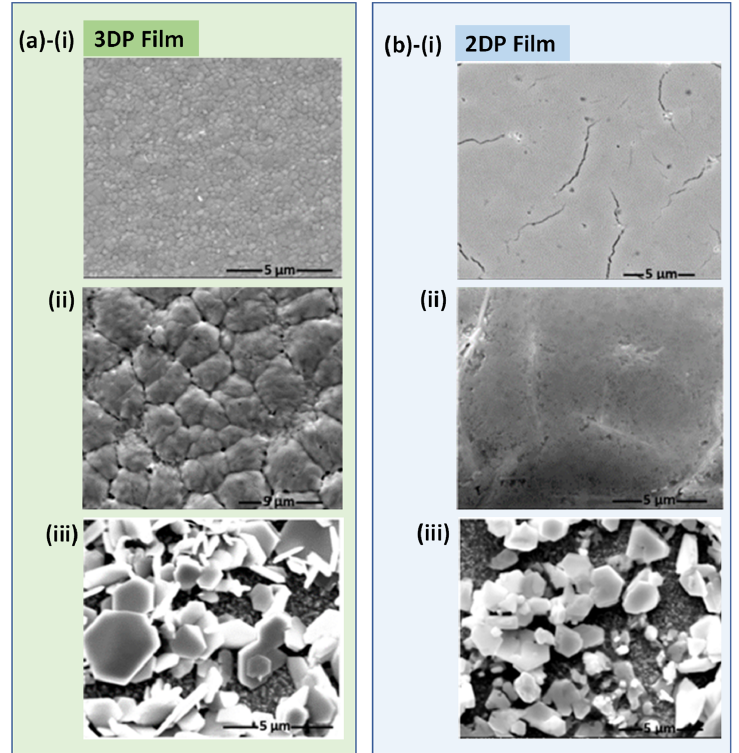
Figure 5. Surface morphology characterization studies conducted on spin coated 3DP and 2DP on top of FTO substrates for three cases, ( i ) freshly deposited films at t = 0 , ( ii ) exposed to room tem ‐ perature ambient (RT) for a duration of 8 h at 25 ˚ C and 45 ± 5 % RH (uncovered), and ( iii ) exposed to 90% RH in an inhouse simulated humidity chamber at ambient temperatures for 30 min. SEM images corresponding to 3DP films that are ( a ) ‐ ( i ) freshly deposited, ( ii ) ambient RT exposed, and ( iii ) exposed to RH > 90%. While the freshly deposited films in ( a ) ‐ ( i ) appear dense, the RT exposed films in ( a ) ‐ ( ii ) reveal signs of void formation, particularly at boundaries separating the grains, while in ( a ) ‐ ( iii ), the films have disintegrated, and the substrate is also discolored. SEM image correspond ‐ ing to 2DP films that are ( b ) ‐ ( i ) freshly deposited, ( ii ) ambient RT exposed, and (iii) exposed to RH > 90%. Unlike the case for the 3DP film, the 2DP film still appears smooth and dense in ( ii ) after it is